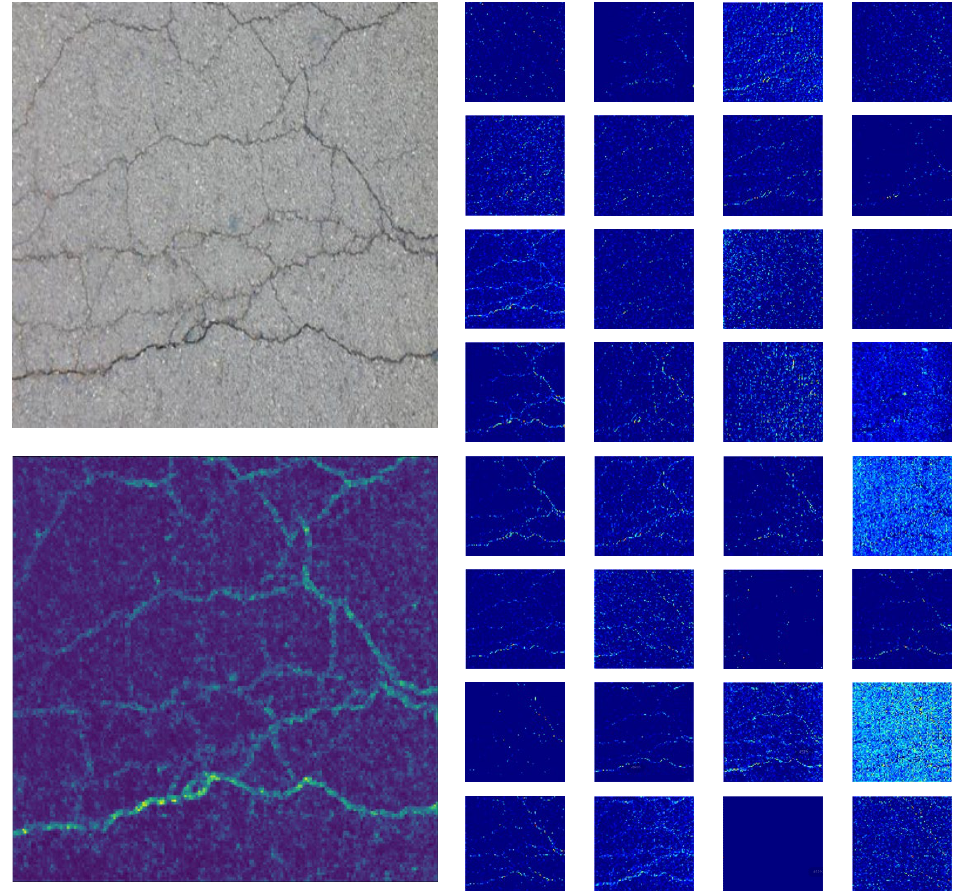
Figure 9. Input image ( top left ), feature maps of the second stage in VGG-16, and fused image of feature maps ( bottom left ). The pictures are represented using 32 bits.